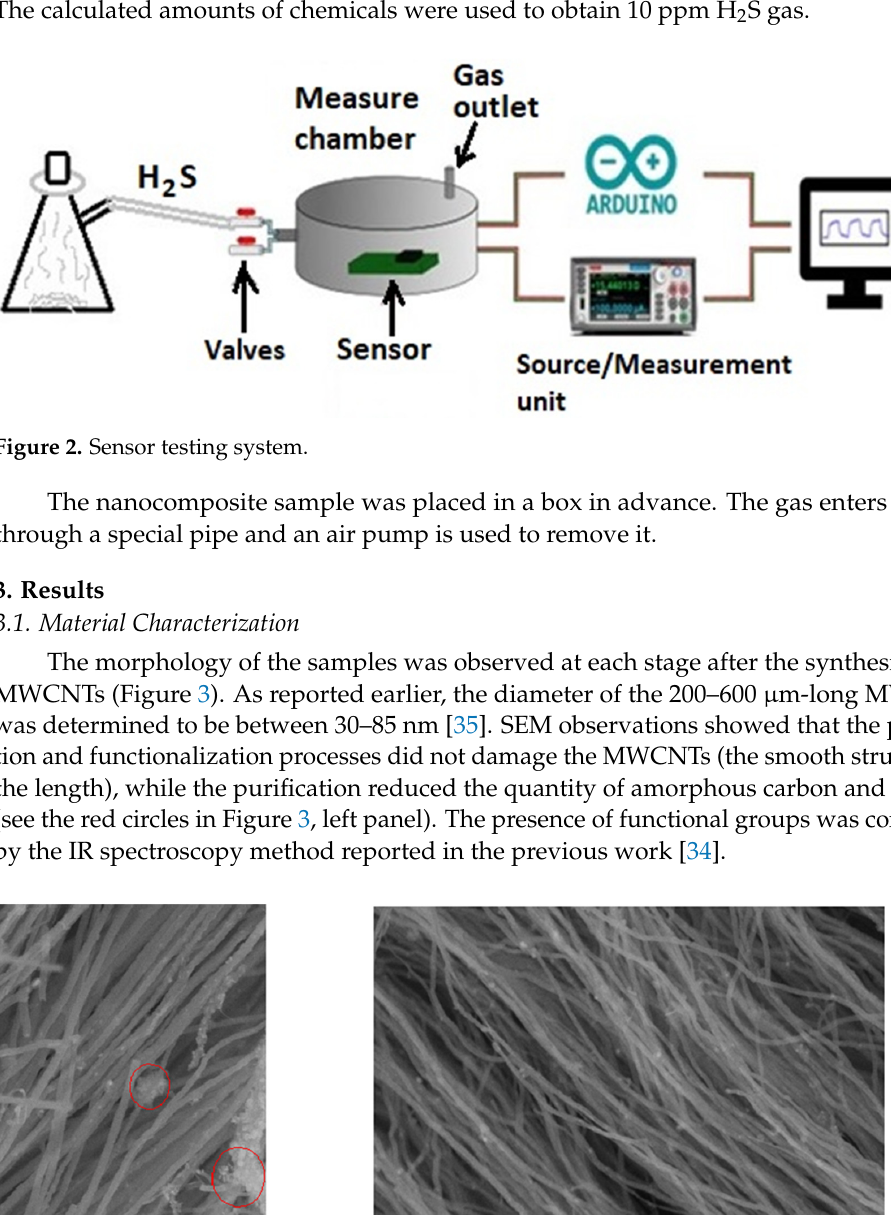
Figure 1. Sensor structure ( left ) and I ‐ V characteristics of the Ag ‐ f ‐ MWCNTs/Cu ‐ Ag structures ( right ).